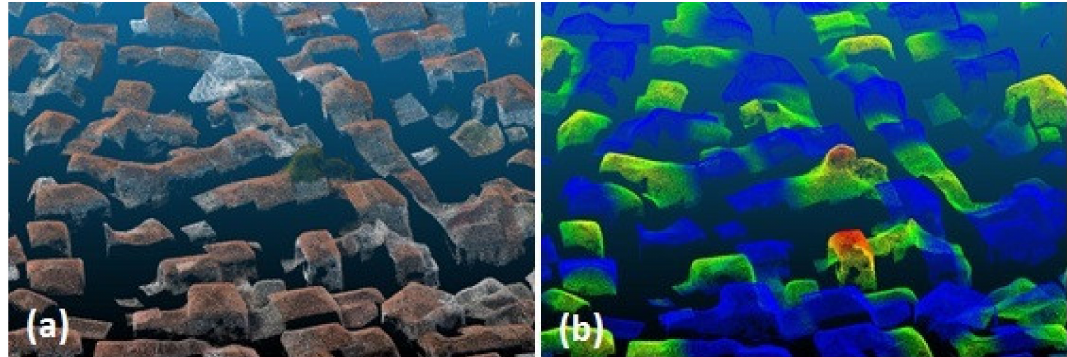
Figure 9. Trees over house roofs lead to the biggest negative values and, thus, errors in cloud to cloud comparison ( a ) point cloud of the study area and ( b ) cloud to cloud